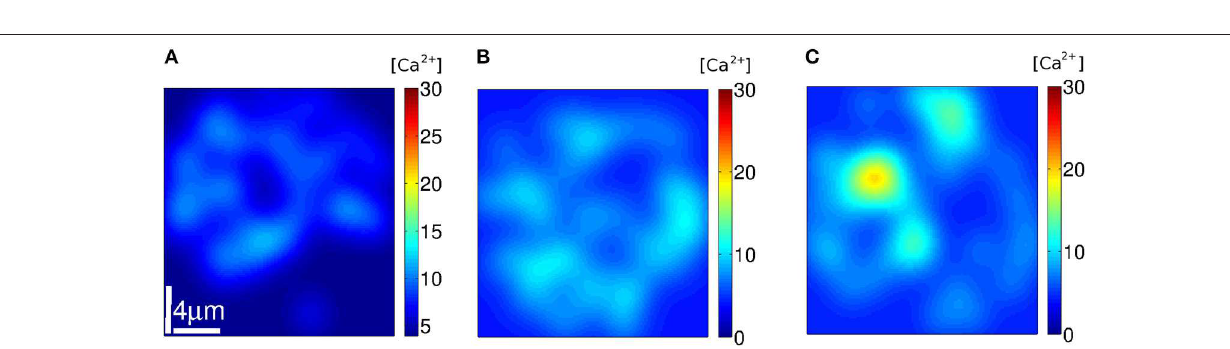
FIGURE 9 | [Ca 2 + ] distribution of events in three instants (A–C) of stochastic simulations with a mean separation between clusters of 0.4 µ m and δ Ca (condition S3 ). Example (A) corresponds to N o